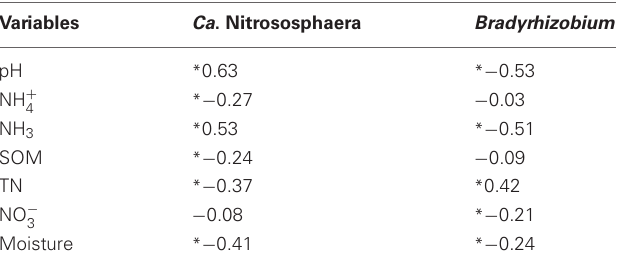
Table 5 | Spearman correlation (rho) for Broadbalk experiment at Rothamsted research (BRR), the Everglades Agricultural Area (EAA) and the Kellogg Biological Station (KBS) between relative abundance of Ca. Nitrososphaera, Bradyrhizobium and soil features (TN, total nitrogen; NH + , ammonium; NH 3 , ammonia; NO − , nitrate; Moisture; 3 4 SOM, organic matter and pH).